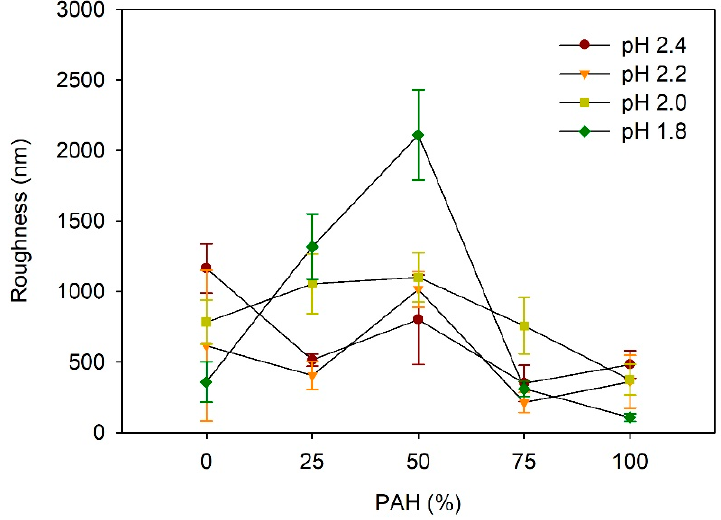
Figure 4. Influence of PAH ratio on the roughness of LbL films treated at different pH values.